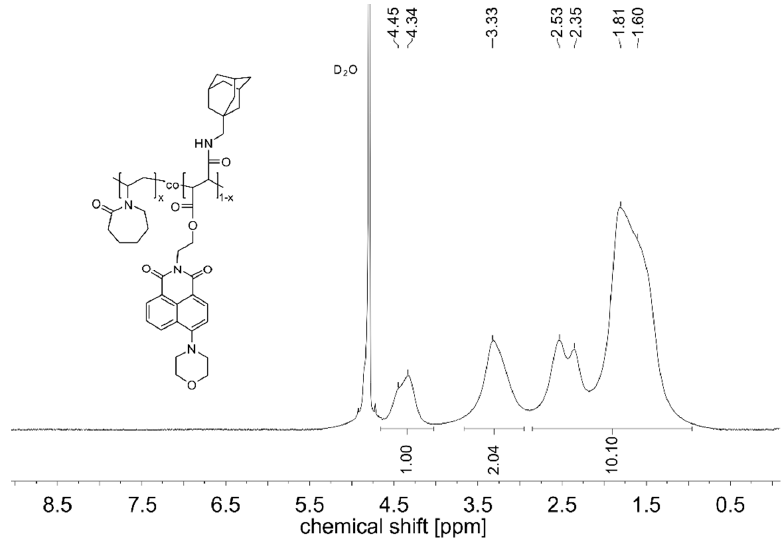
Figure 2. 1 H-NMR spectrum of copolymer PNVCL-g in D 2 O at ambient